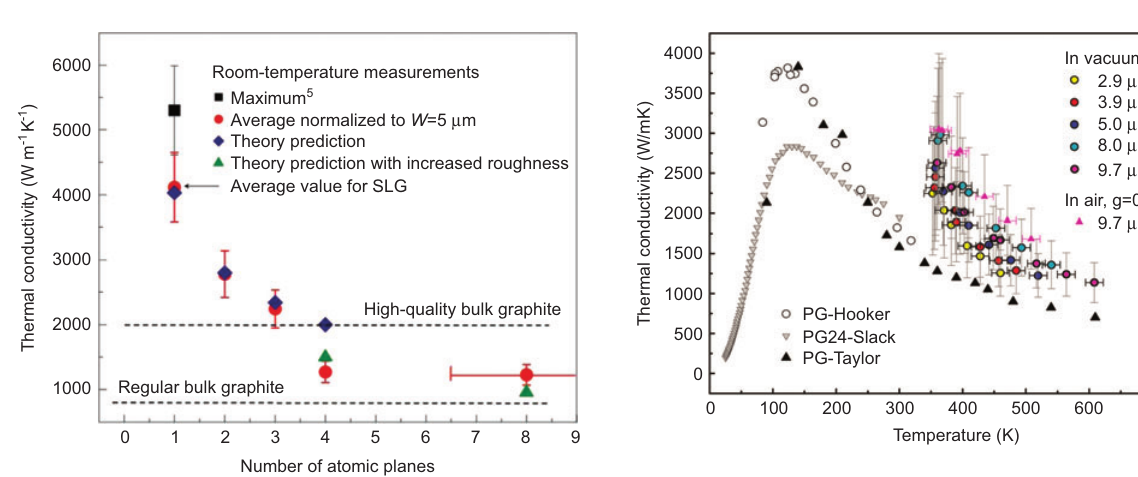
Figure 2 Measured thermal conductivity as a function of the num- ber of atomic planes in FLG (few-layers graphene). The dashed straight lines indicate the range of bulk graphite thermal conduc- tivities. The blue diamonds were obtained from the fi rst-principles theory of thermal conduction in FLG based on the actual phonon dis- persion and accounting for all allowed three-phonon Umklapp scat- tering channels. The green triangles are Callaway-Klemens model calculations, which include extrinsic effects characteristic for thicker fi lms. (Reproduced from Ref. [25] with permission from the Nature Publishing Group.)